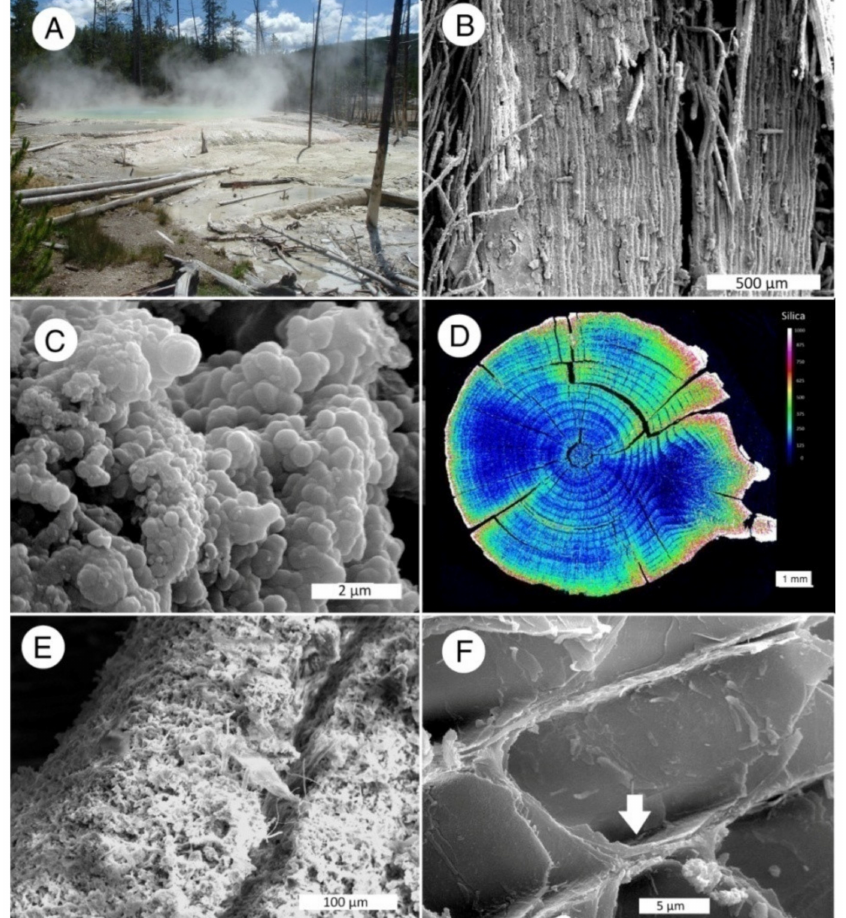
Figure 45. Silica precipitation in wood in modern hot springs at Yellowstone National Park, Wyoming, USA. ( A ) Cistern Spring, Norris Geyser Basin, showing abundance of lodgepole pine ( Pinus contorta ) trunks that fell into the spring, where they become encrusted with amorphous silica. ( B ) Wood cells encrusted with amorphous silica, Beehive Geyser, Upper Geyser Basin. The wood fibers were beginning to dissociate in the hot spring environment as silica was precipitating. ( C ) Opal-A lepispheres in crust enclosing a twig from Cistern Spring. ( D ) X-ray map showing silica distribution in a lodgepole pine twig from Cistern Spring. Red and orange colors show silica in the outermost zone, and penetrating along fractures [81]. ( E ) Silica crust on twig from Cistern Spring. The fibrous texture is of microbial origin; silica occurs as opal-A microspheres. ( F ) Interior of the same wood region is relatively unmineralized, with silica occurring only as incipient layers within cell walls (shown by